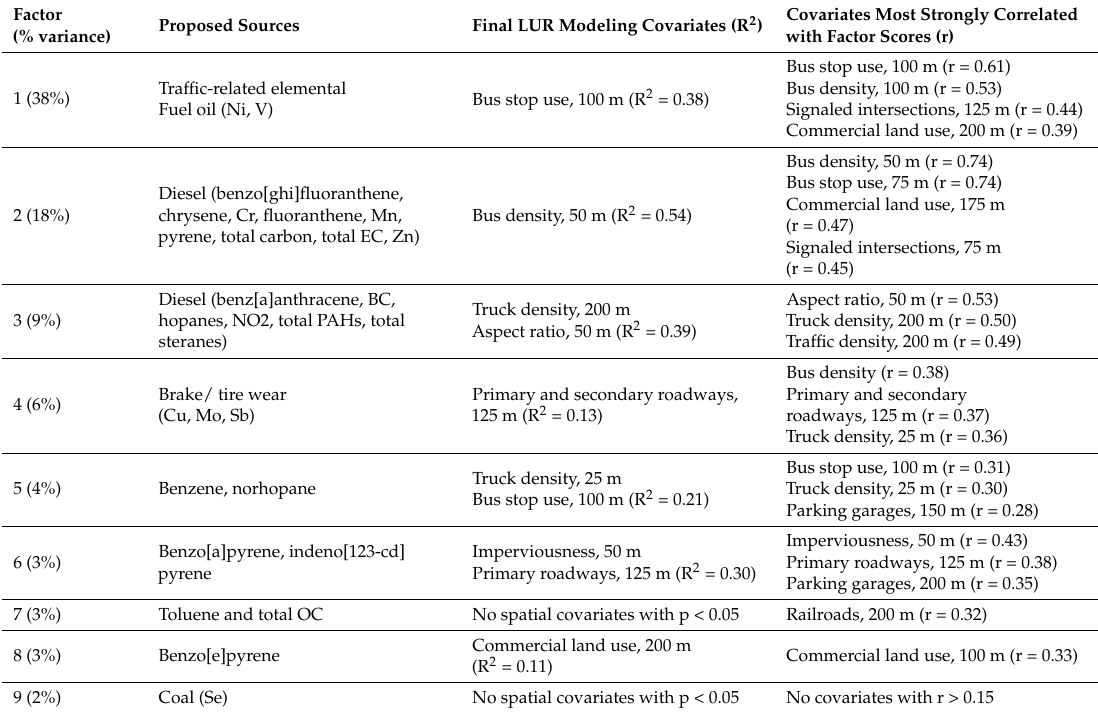
Table 3. Summer factor score LUR (land use regression) results ( n = 36).